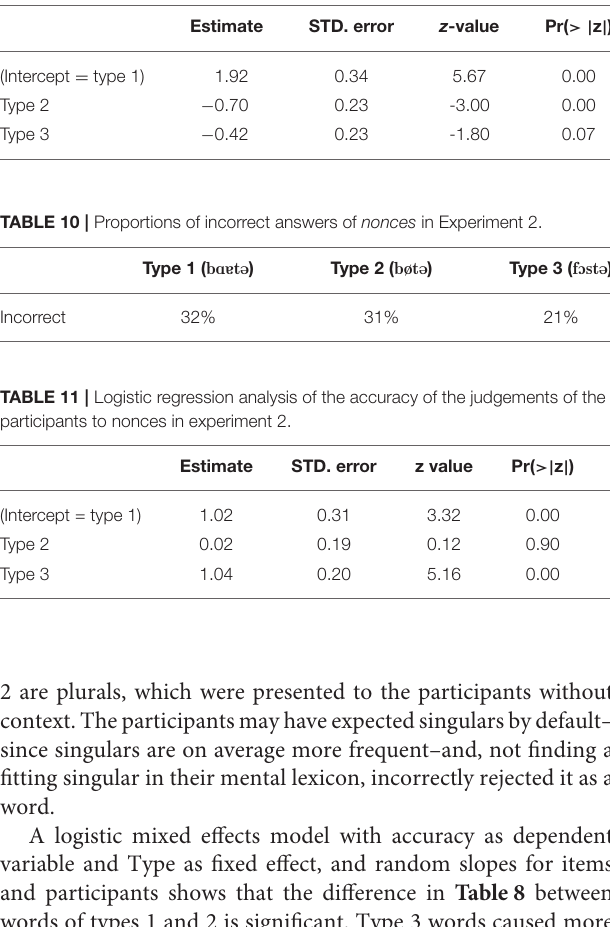
TABLE 9 | Logistic regression analysis of the accuracy of the judgements of the participants to words in experiment 2.